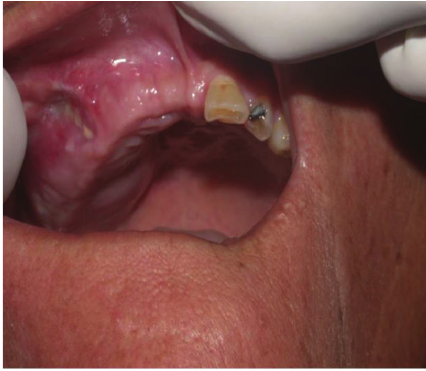
Figure 1: Initial aspect of the injury. Figure 2: Photomicrograph showing the cribriform pattern of the ACC.